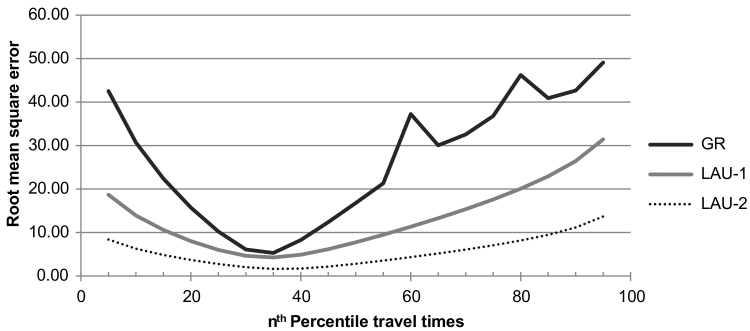
Root mean square errors for 5th to 95th percentile travel times meant to represent interaction-weighted travel times between two zones.